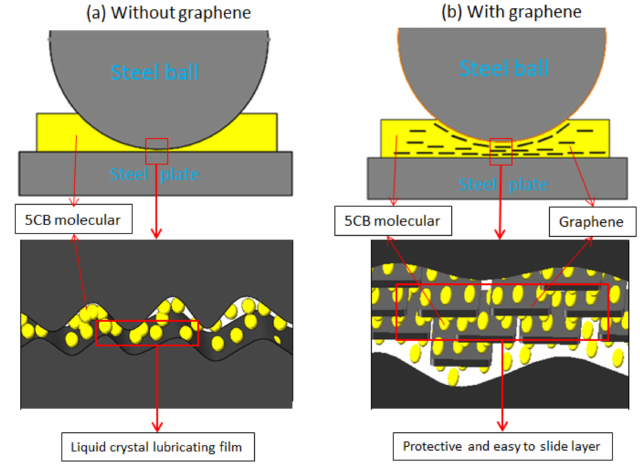
Figure 9. Scheme of lubrication mechanism: ( a ) Lubricated with 5CB; ( b ) lubricated with 5CB+0.15 wt.% G